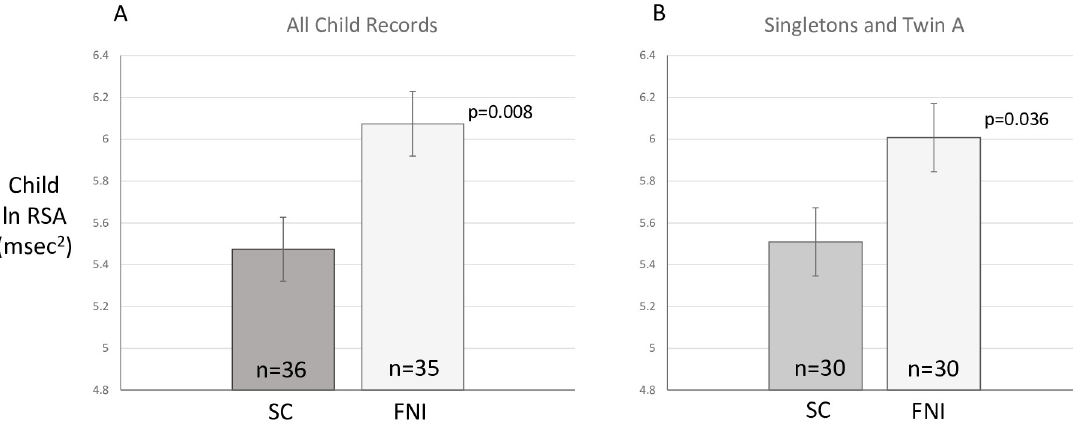
Fig 2. Means ( ± SE) of RSA for children at the 5-year follow-up during the lap-test. The set of bars on the left show results for all children and the set of bars on the right show these results when including only singletons and twin